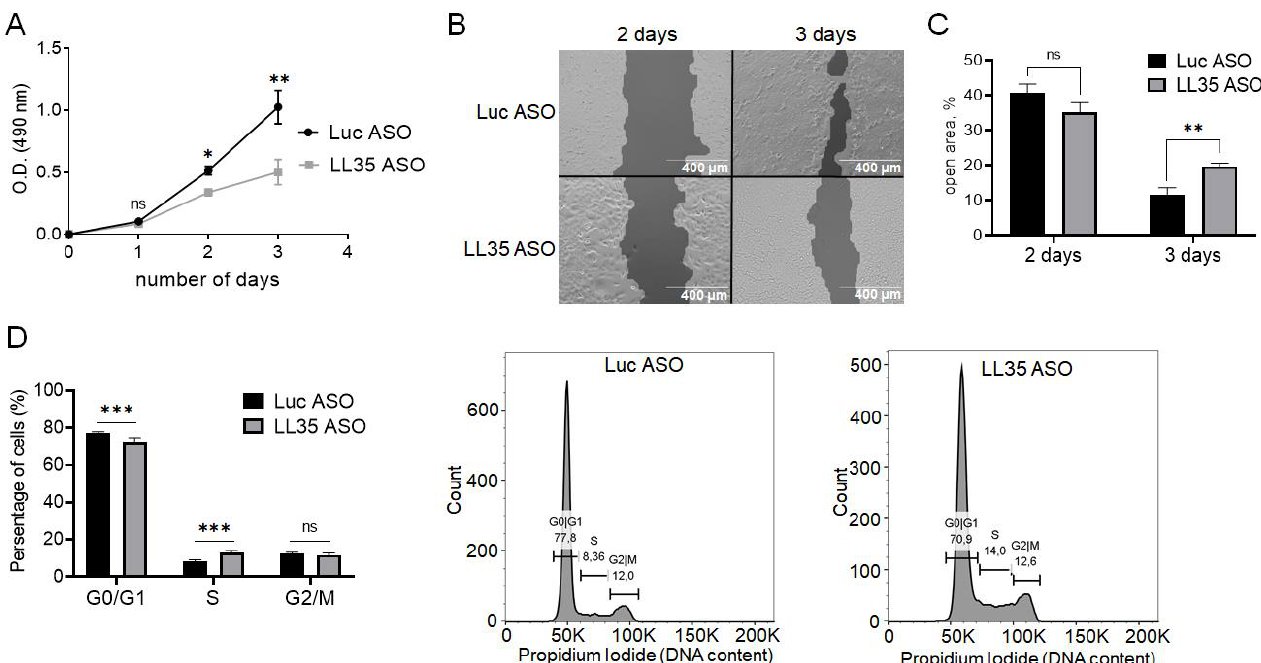
Figure 7. ( A ) Study of hepatocyte survival after LL35 depletion (LL35 ASO) in comparison with control cells (Luc ASO). ( B ) Wound healing assay for AML12 cells after LL35 knockdown and control. ( C ) Quantification of wound healing assay with ImageJ software. ( D ) Cell cycle analysis of the cells with LL35 knockdown and control cells by flow cytometry. Percentage of cells in different cell cycle phases after LL35 knockdown compared with control obtained from flow cytometry analysis after PI staining. Results show mean ± SD. ns—not significant. * p < 0.05, ** p < 0.01 and *** p <